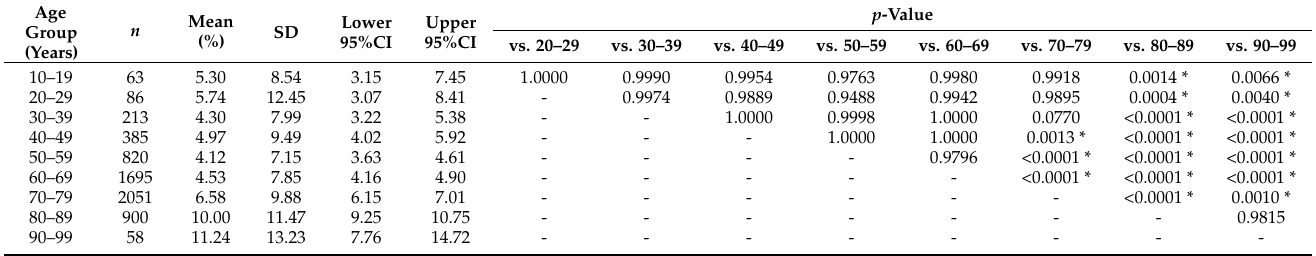
Table 4. FN stratified by age.